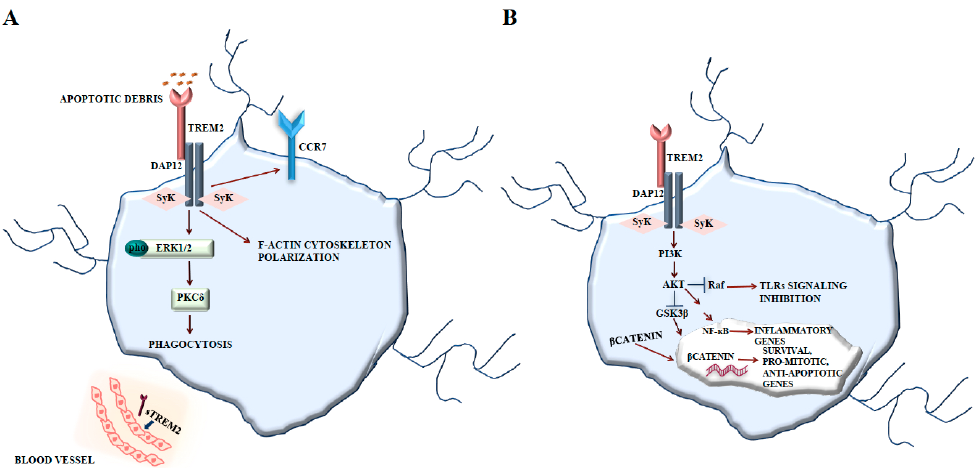
Figure 1. TREM2-DAP12 signaling. ( A ) TREM2 signals via DAP12 and stimulates the